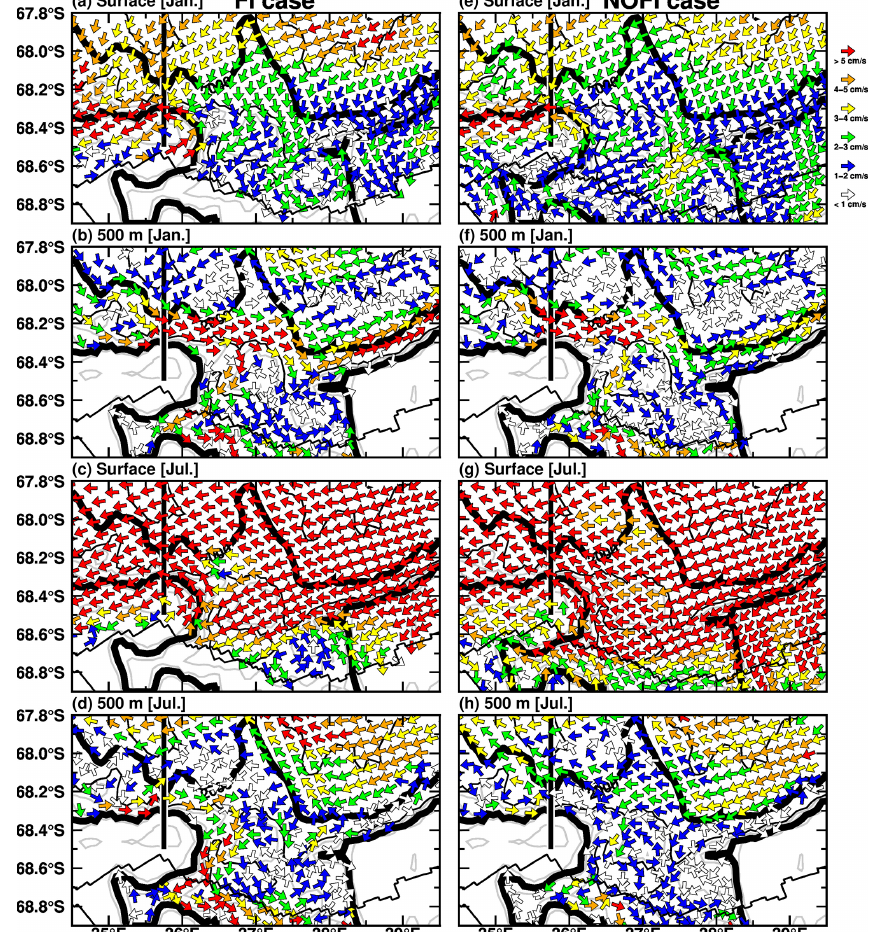
Figure 17. Maps of surface and intermediate-depth (at 500m) ocean flows in January (upper four panels) and July (lower four panels). The vector shows the ocean flow direction, and the color shows the magnitude. Left and right panels show results from the FI and NOFI cases, respectively. The vertical black line indicates the sections used for Figs. 18 and 19. The black contours show the water depth with the 1000m interval. The thick black curves show the 500 and 2000m depth contours to represent the upper continental slope. The zigzag lines are the coastline and the fast-ice